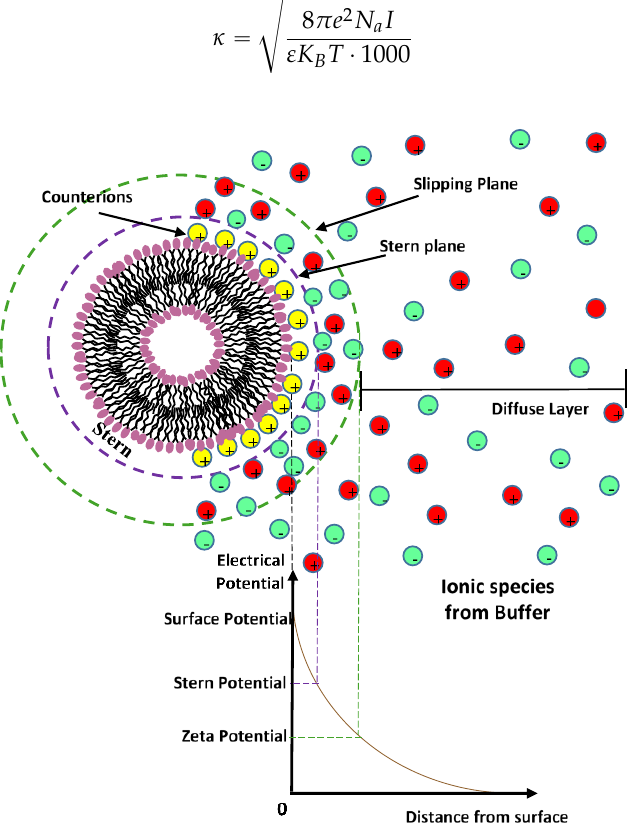
Figure 2. Schematic representation of the charge distribution around the charged surface of a liposome. The electrical double layer (EDL) is composed of a layer of ions strongly bound to the charged surface (Stern layer) and an adjacent region of loosely associated mobile ions (diffuse layer).